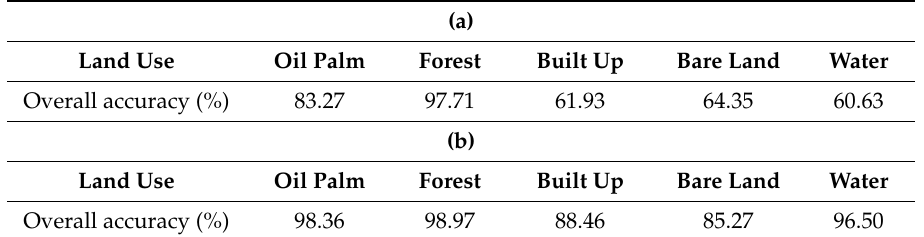
Table 5. Accuracy (%) of each land cover before ( a ) and after ( b ) the misclassified land covers were removed from oil palm areas.